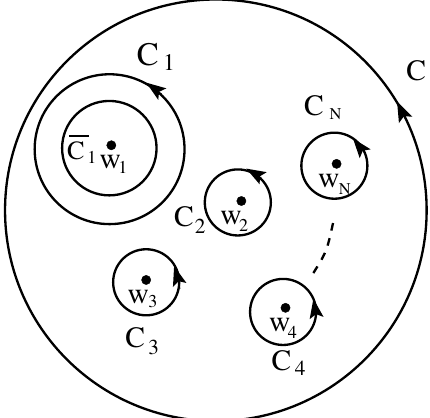
Figure 2 . Boundary contour C shrinks to the sum of contours C i , i = 1 , · · · N . Here ¯ C 1 and C i , i = 2 , · · · N are the contours in the integral expression of the operators J a the primary fields, φ s ( w i ) , at points w i , i = 1 , · · · N . We have that C 1 ⊃ ¯ C 1 i